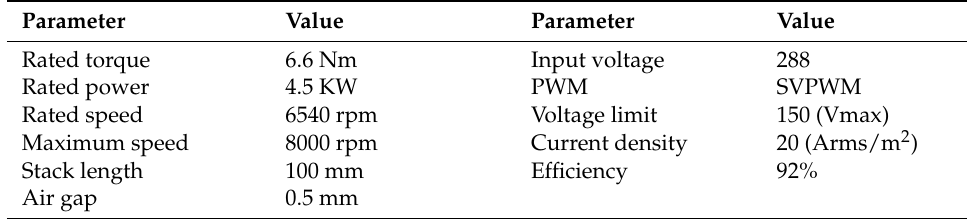
Figure 2. Analysis model and experimental setup: ( a ) SPMSM, ( b ) IPMSM. Table 1. Design